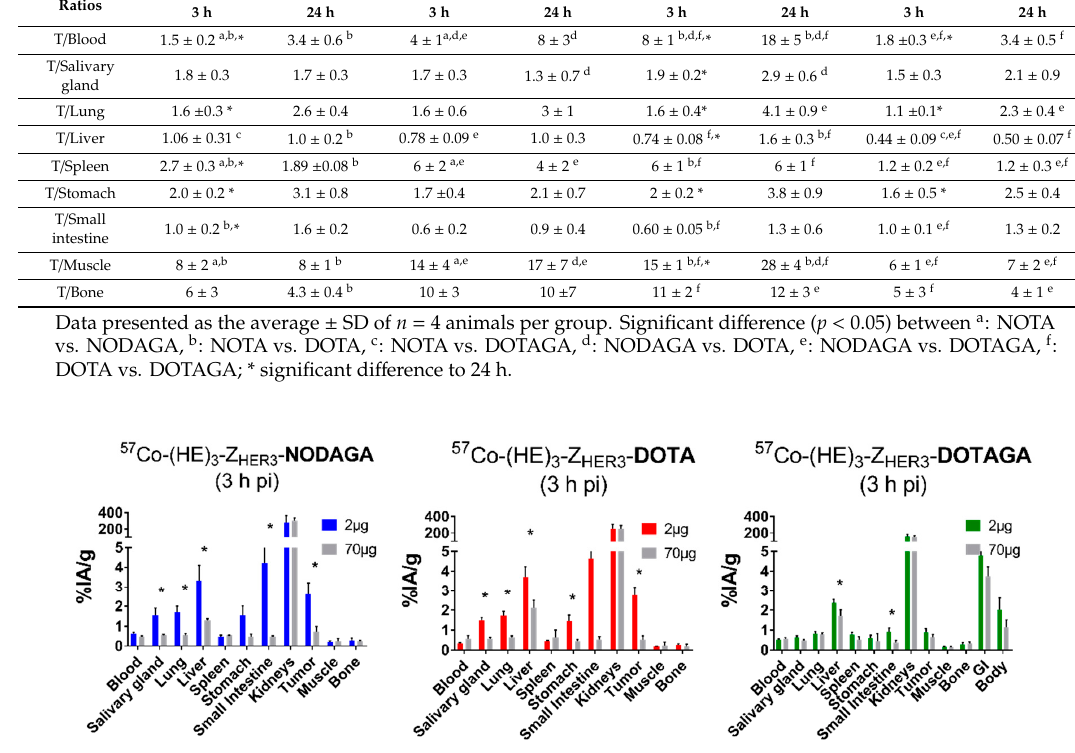
Table 4. Tumor-to-organ ratios. Female Balb / c nu / nu mice with HER3-expressing BxPC-3 xenografts were injected with 2 µ g [ 57 Co]Co-(HE) 3 -Z HER3 -X (X = NOTA, NODAGA, DOTA, DOTAGA).